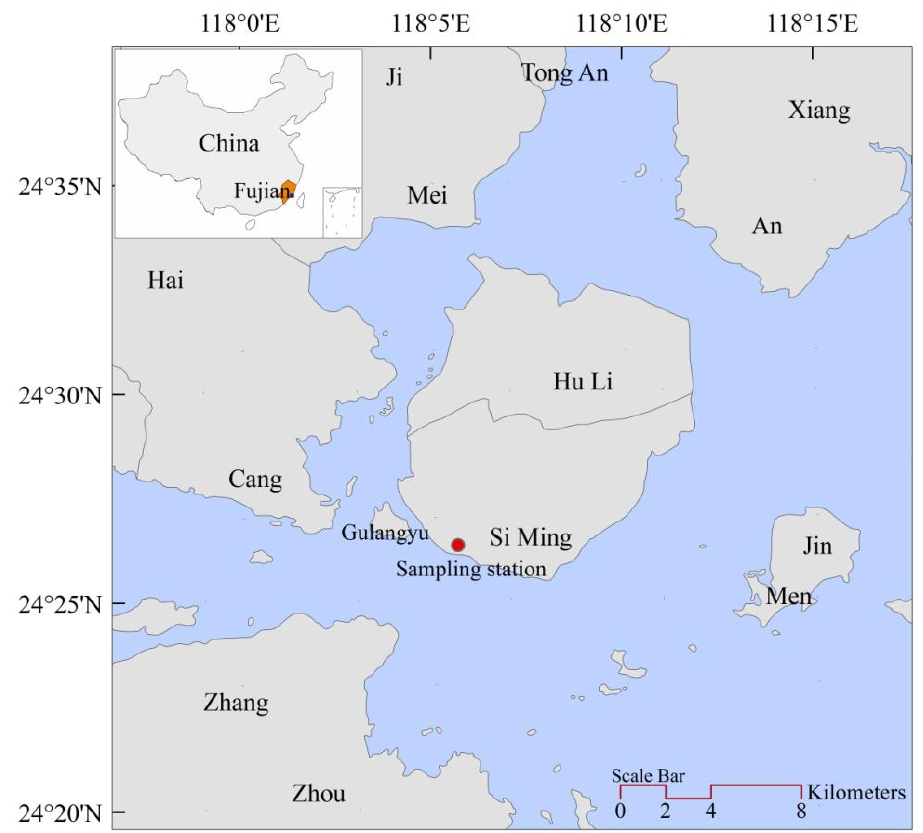
Figure 1. Map of Xiamen Island and the sampling site.